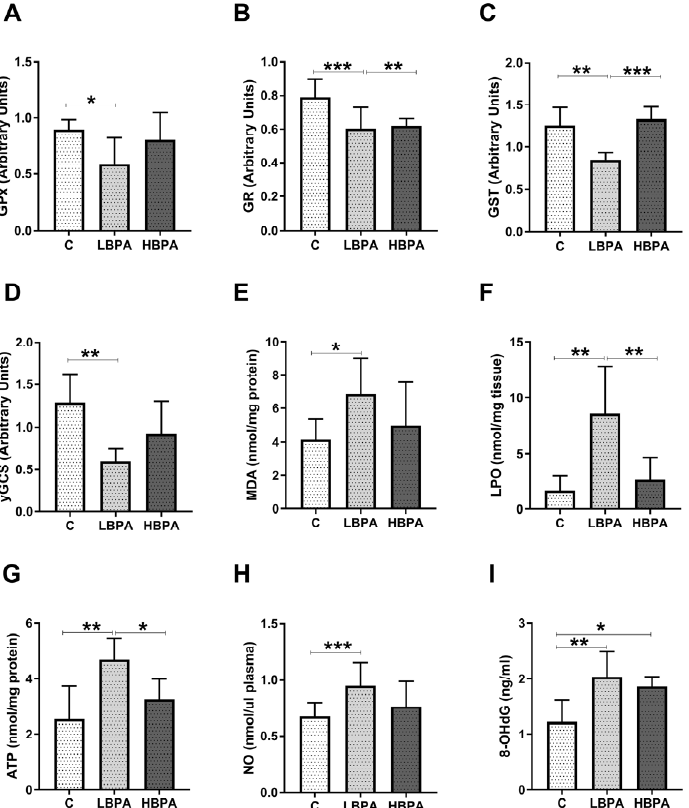
Figure 7. Effects of perinatal exposure to BPA on gene expression profile of GSH-related enzymes and oxidative damage in livers from female PND6 offspring. ( A ) Glutathione peroxidase (GPx); ( B ) glutathione reductase (GR); ( C ) glutathione S-transferase (GST); ( D ) γ -glutamylcysteine synthetase ( γ -GCS) relative gene expression. ( E ) Malondialdehyde (MDA) content in nmol/mg protein. ( F ) Lipid hydroperoxide content in nmol/mg tissue. ( G ) Adenosine triphosphate (ATP) levels in nmol/mg protein. ( H ) Concentration of nitric oxide metabolites (NO) in nmol/ µ L plasma. ( I ) Concentration of 8-oxo-2 (cid:48) -deoxyguanosine (8-OHdG) in ng/mL. Data represent mean ± SD. For ELISA assay, n = 12 control PND6 offspring; n = 12 LBPA PND6 offspring; n = 12 HBPA PND6 offspring (two replicates for each sample). For mRNA, n = 12 control PND6 offspring; n = 12 LBPA PND6 offspring; n = 12 HBPA PND6 offspring (three replicates for each gene). Statistical significance was determined by one-way ANOVA. * p < 0.05; ** p < 0.01; *** p <